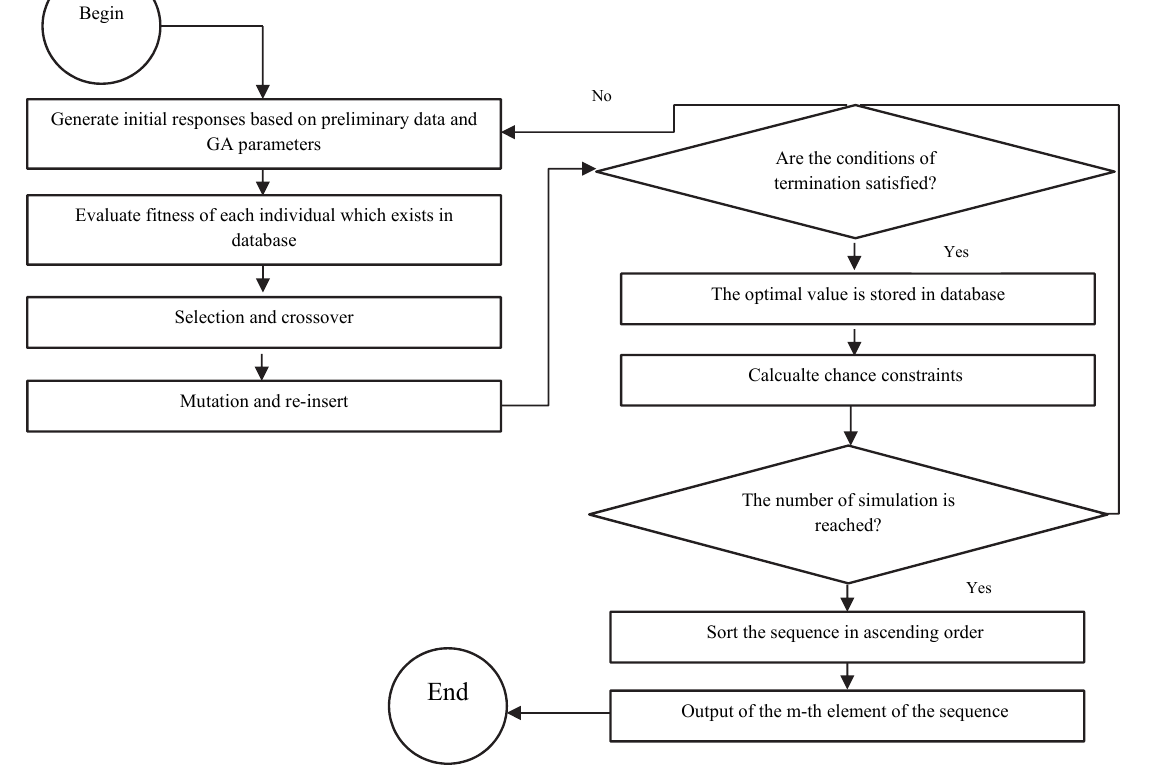
Fig 2 . Implementation of the proposed solution algorithm Range of changes for the input stochastic data of MATLAB software